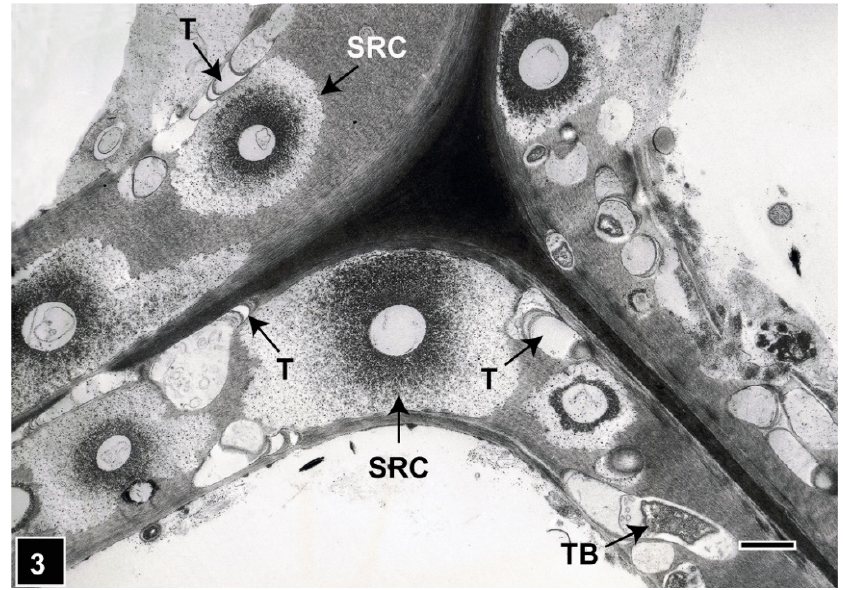
Figure 3. TEM of a transverse section through Pinus radiata tracheids attacked by soft-rot fungi and tunnelling bacteria. Soft-rot cavities (SRC) display a diffuse degradation pattern. Tunnelling bacteria (TB) and tunnels (T) are present in cell wall regions not occupied by soft-rot cavities. All cell wall regions, including the highly lignified middle lamella and S3 layer, are degraded by TB. Scale bar = 2 µm. The image is reproduced from Singh et al. (2019) IAWA J.